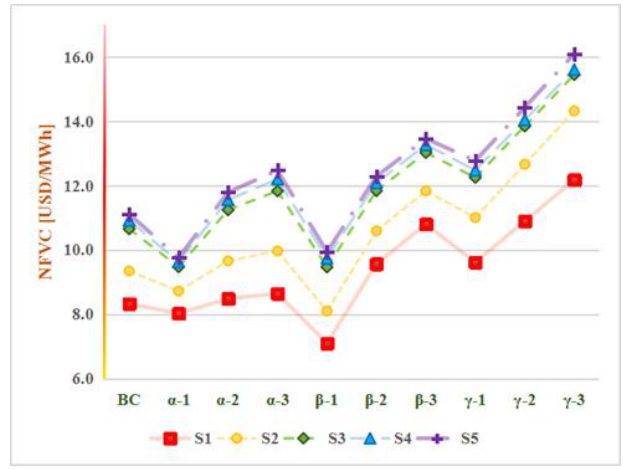
Figure 6. Non-fuel variable costs ( NFVC ) of the units from natural gas cluster for different scenarios and cases.